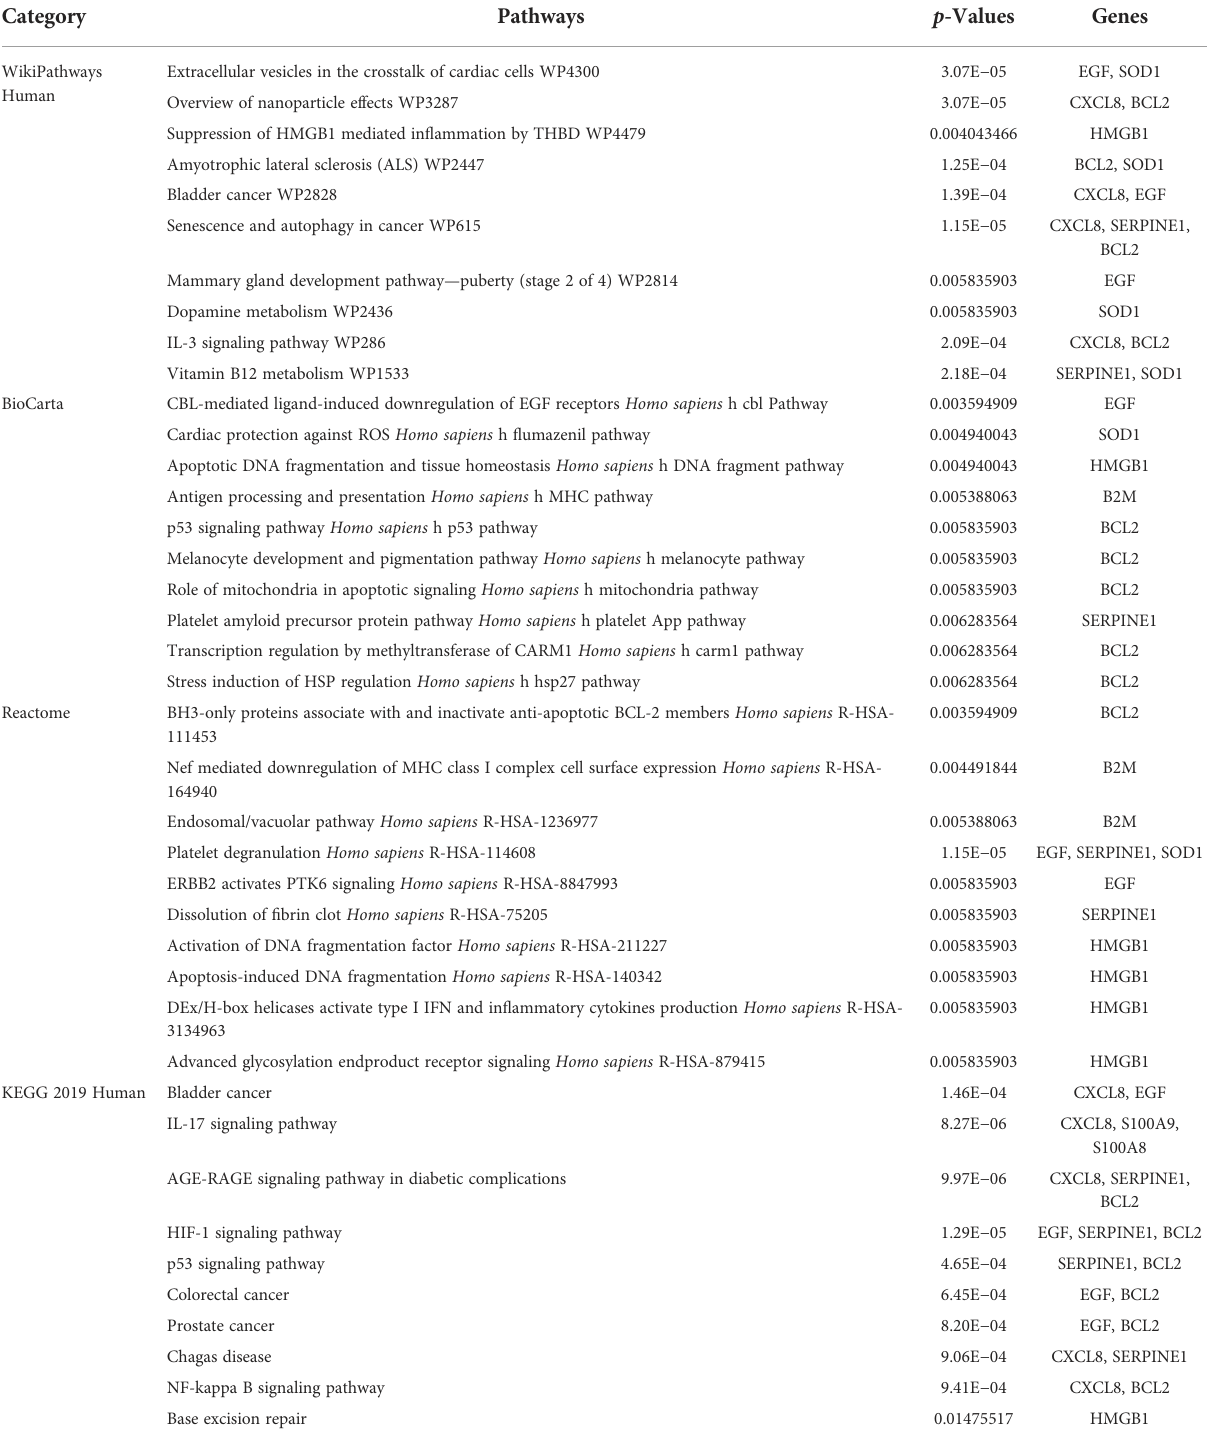
TABLE 3 Pathway enrichment analysis of common genes among Long COVID and